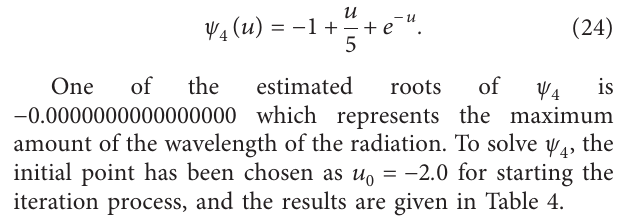
Example 3. Van Der Wall’s